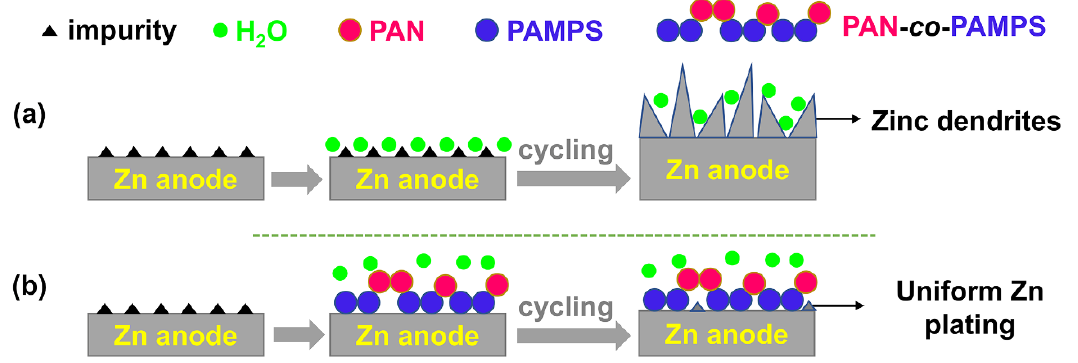
Figure 1. Schematic illustration of the Zn-stabilizing mechanism of PAN- co -PAMPS. Molecule distribution at the surface of Zn anode of Zn|Zn symmetric cell using ( a ) pristine and ( b ) additive- containing